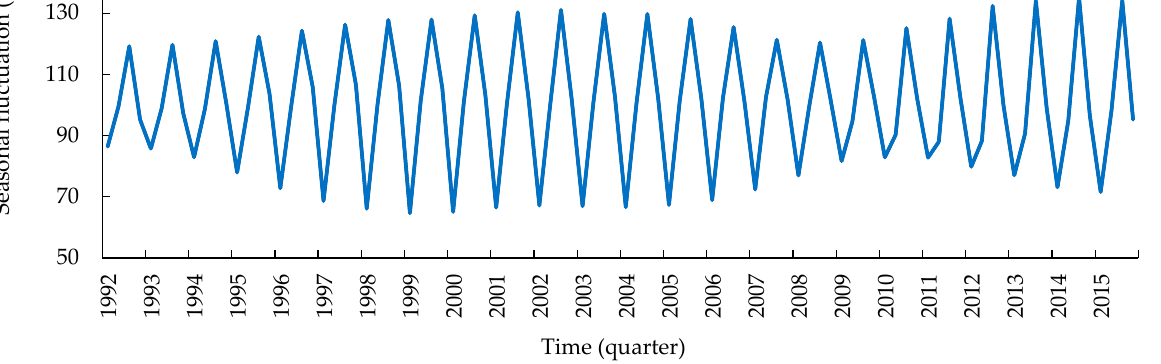
Figure 2. Decomposition of time series of sawlog price, including seasonal fluctuation indices in Hyrcanian forest in 1992–2015.